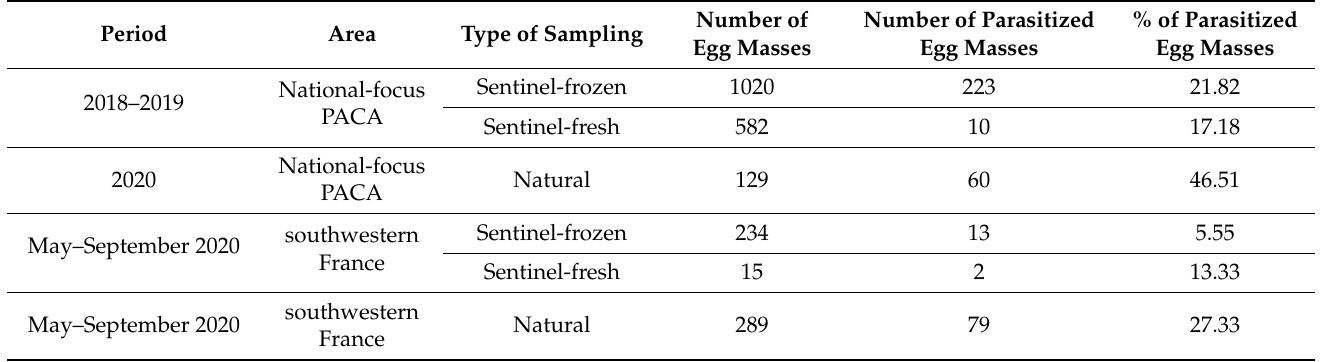
Table 1. Summary of the different main sampling